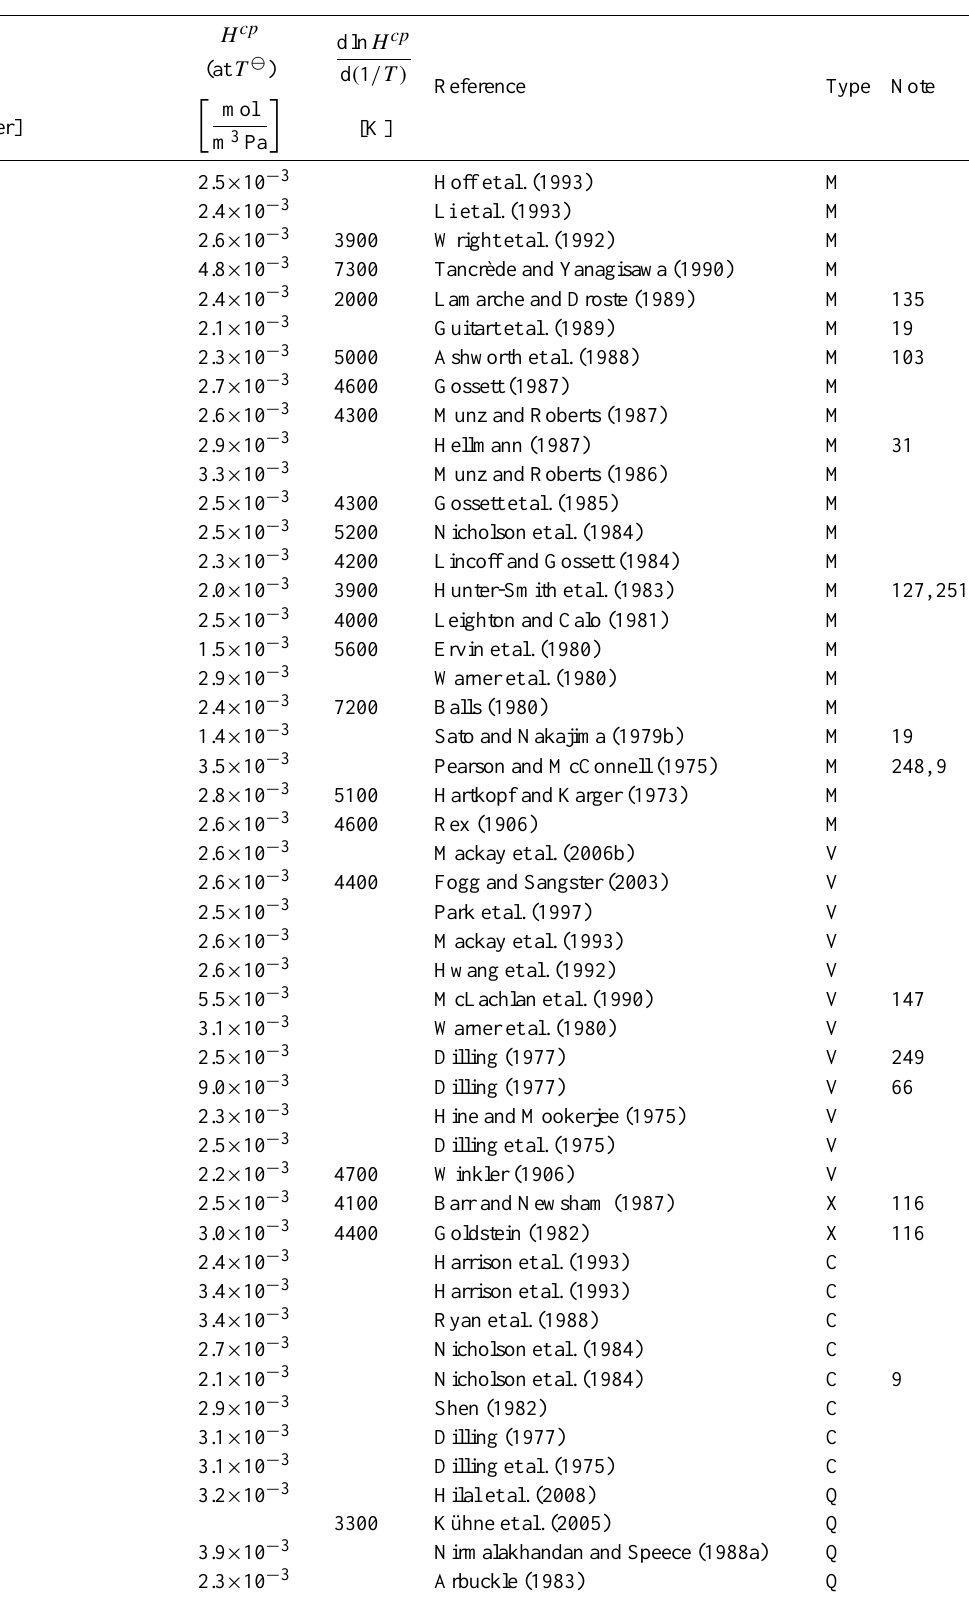
Table 6: Henry’s law constants for water as solvent (...continued)